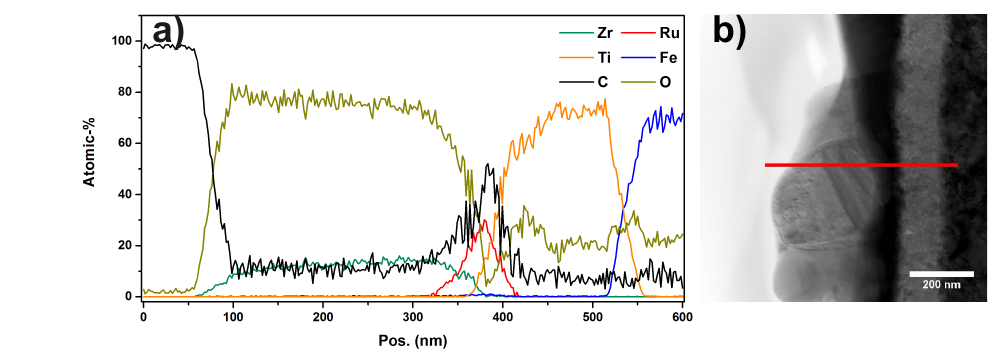
Figure 20. ( a ) EDX linescan of sample “Ru/Ti-3” showing the signal intensities of different elemental peaks. The layer structure is evident by inspecting the intensity ratios; ( b ) STEM DF image, the marker indicates the region in which the linescan was